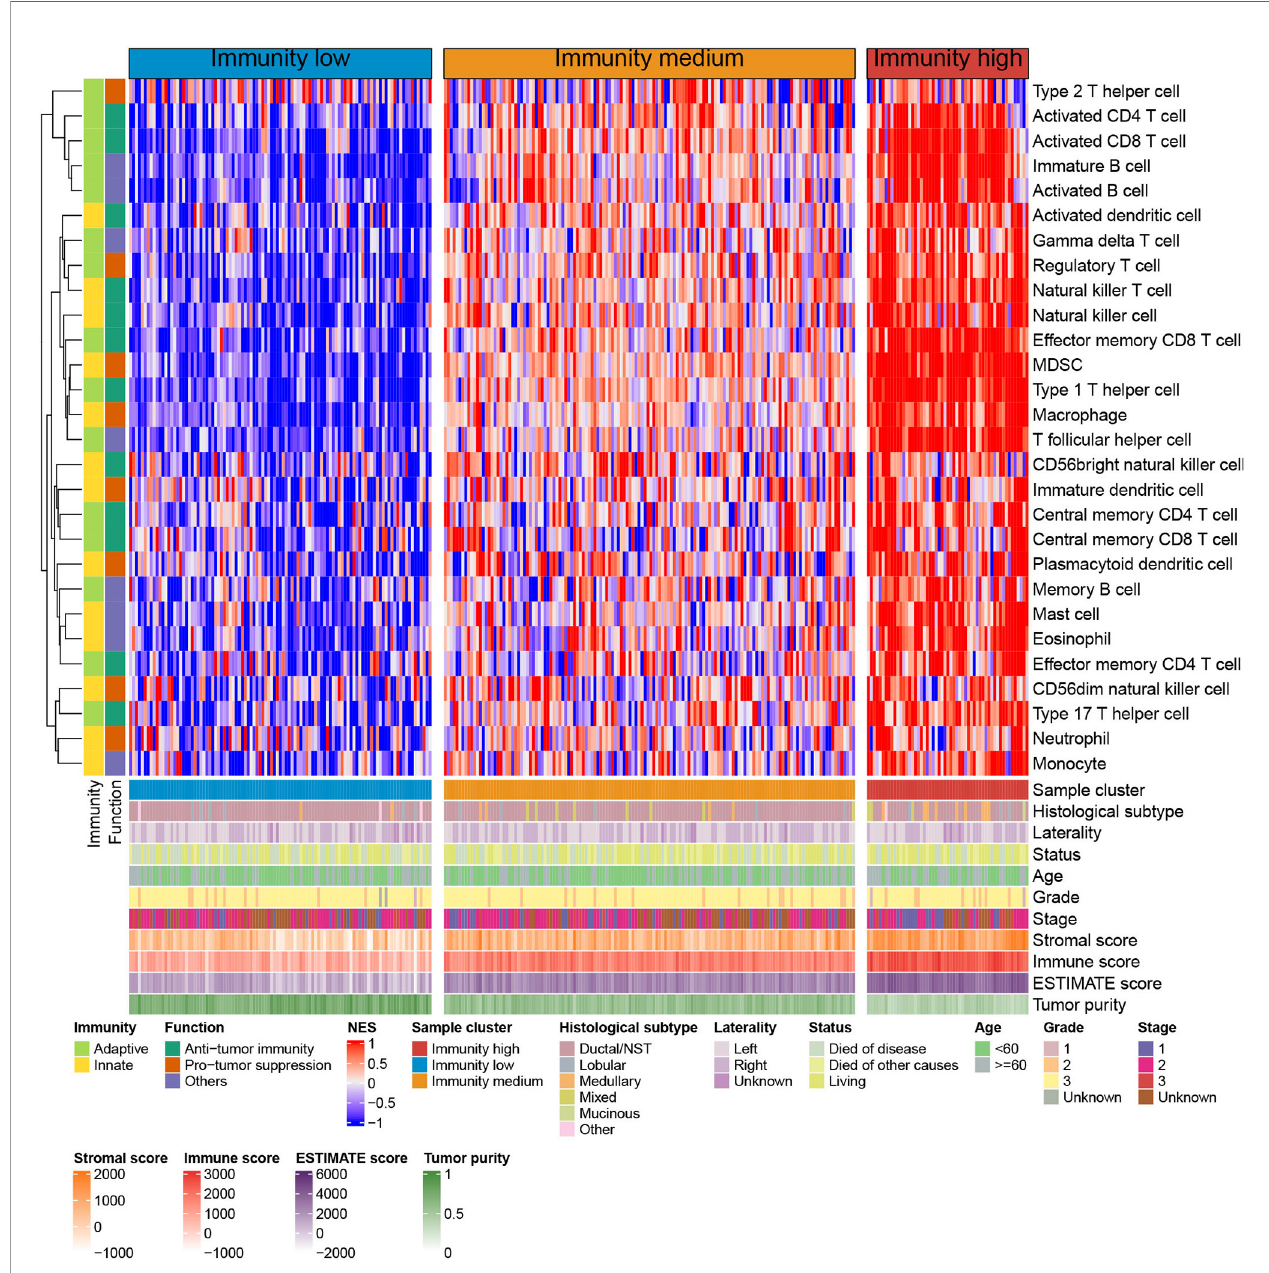
FIGURE 7 | Unsupervised clustering of TNBC microenvironment phenotypes in the METABRIC cohort. Rows represent tumor-in fi ltrating immune cells and columns represent